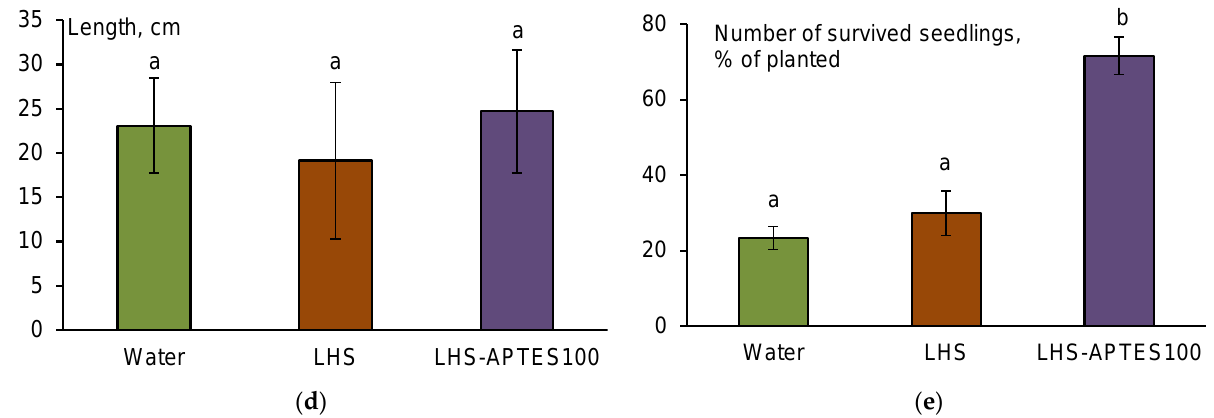
Figure 6. Biological effects of LHS-APTES amendment in the Urbic Technosol: ( a ) Effect on the substrate-induced respiration (SIR); ( b ) Effect of the microbial biomass microbial biomass (Cmic); ( c ) Effect of the extracted dissolved organic carbon (DOC) on the length of T. aestivum seedlings; ( d ) Effect on the length of T. aestivum seedlings grown in the amended soils: ( e ) Effect on the number of T. aestivum seedlings grown in the amended soils. Error bars represent standard deviations ( n = 4). Values with different letters are significantly different at p < 0.05.